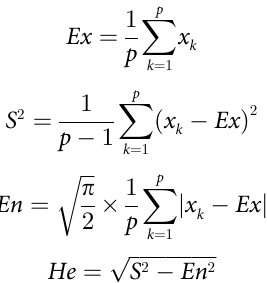
ffiffiffiffiffiffiffiffiffiffiffiffiffiffiffiffiffi p S 2 (cid:0) En 2